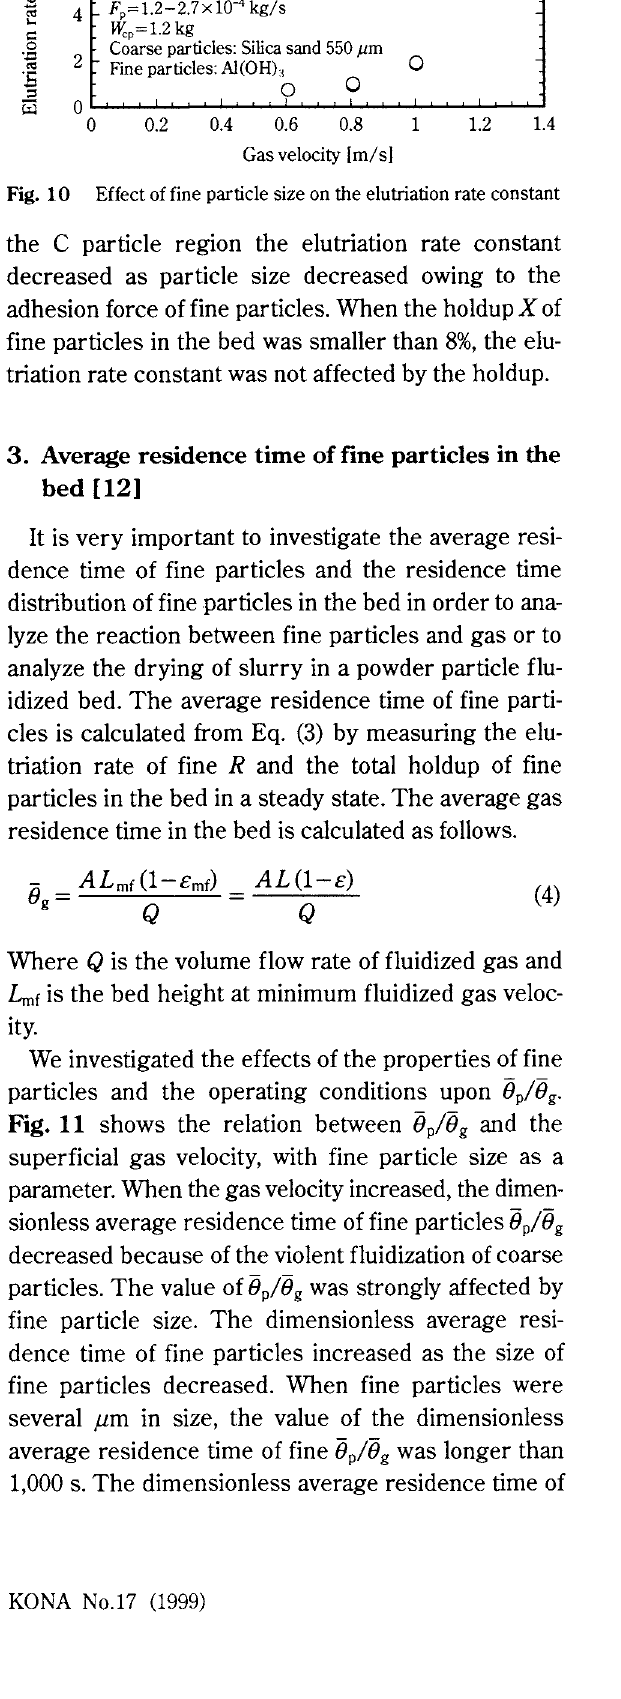
Fine particles: AI(OH} 1 Coarse particles: Silica sand 550 ,urn